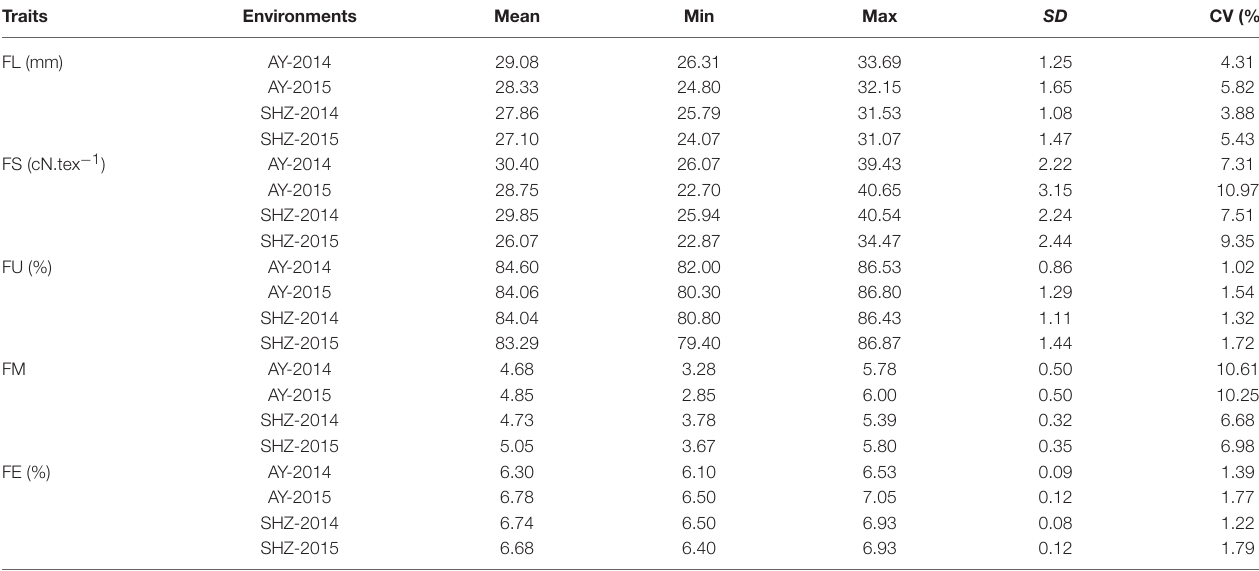
TABLE 1 | Statistics of SNPs. Chr.